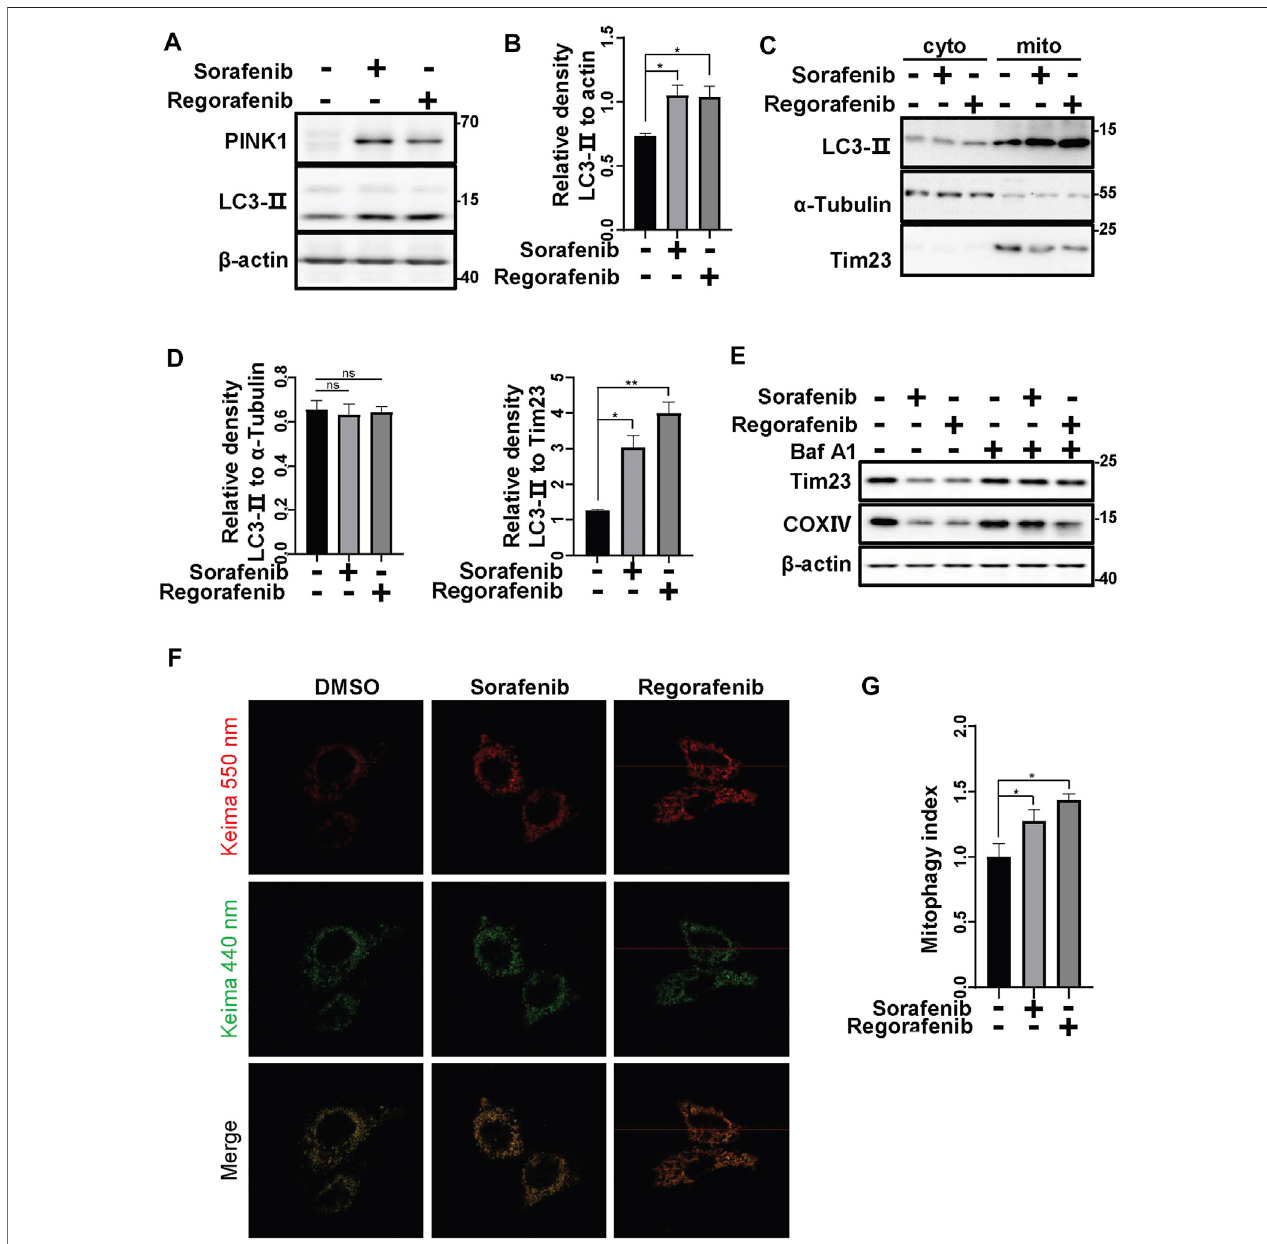
FIGURE4| Sorafenibandregorafenibinducemitophagy. (A) HepG2cellsweretreatedwithsorafenib(20 μ M)orregorafenib(30 μ M)for12 h.LC3-II proteinlevels weredetected usingwesternblotting. (B) TherelativedensitiesofLC3-IIwerequanti fi ed,withtheprotein levelnormalized totheloadingcontrols( β -actin).Valuesarethe mean ± SEM from three independent experiments (* p < 0.05, t tests). (C) HepG2 cells were treated with sorafenib (20 μ M) or regorafenib (30 μ M) for 12 h. After treatment, the mitochondrial and cytosolic fractions were separated using a mitochondria isolation kit. LC3-II in the cytosol or mitochondria was labeled with the indicated antibodies. (D) The relative densities of LC3-II werequanti fi ed, withthe protein level normalized to the loading control on mitochondria (Tim23) or inthe cytosol ( α -Tubulin).Valuesarethemean±SEMfromthreeindependentexperiments(* p < 0.05,** p < 0.01,one-wayANOVAandTukey ’ smultiplecomparisonstest). (E) HepG2 cells were pretreated with Baf A1 (100 nM) for 1 h and then treated with sorafenib (20 μ M) or regorafenib (30 μ M) for 12 h. The Tim23 and COXIV proteins were labeled withtheindicatedantibodies. (F) HepG2cellsthatweretransfectedwithmito-keimafor24 handthentreatedwithsorafenib(20 μ M)orregorafenib(30 μ M)for12 hwere subjected to confocal microscopy imaging. (G) The relative fl uorescence densities of the cells were quanti fi ed. Values are the mean ± SEM from three independent experiments (* p < 0.05, t tests).